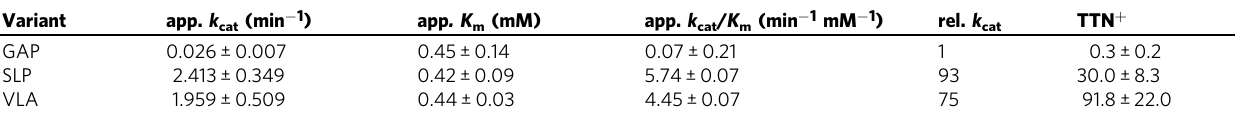
Table 1 Biochemical characterization of selected WelO5* variants for the biocatalytic production of 1a.